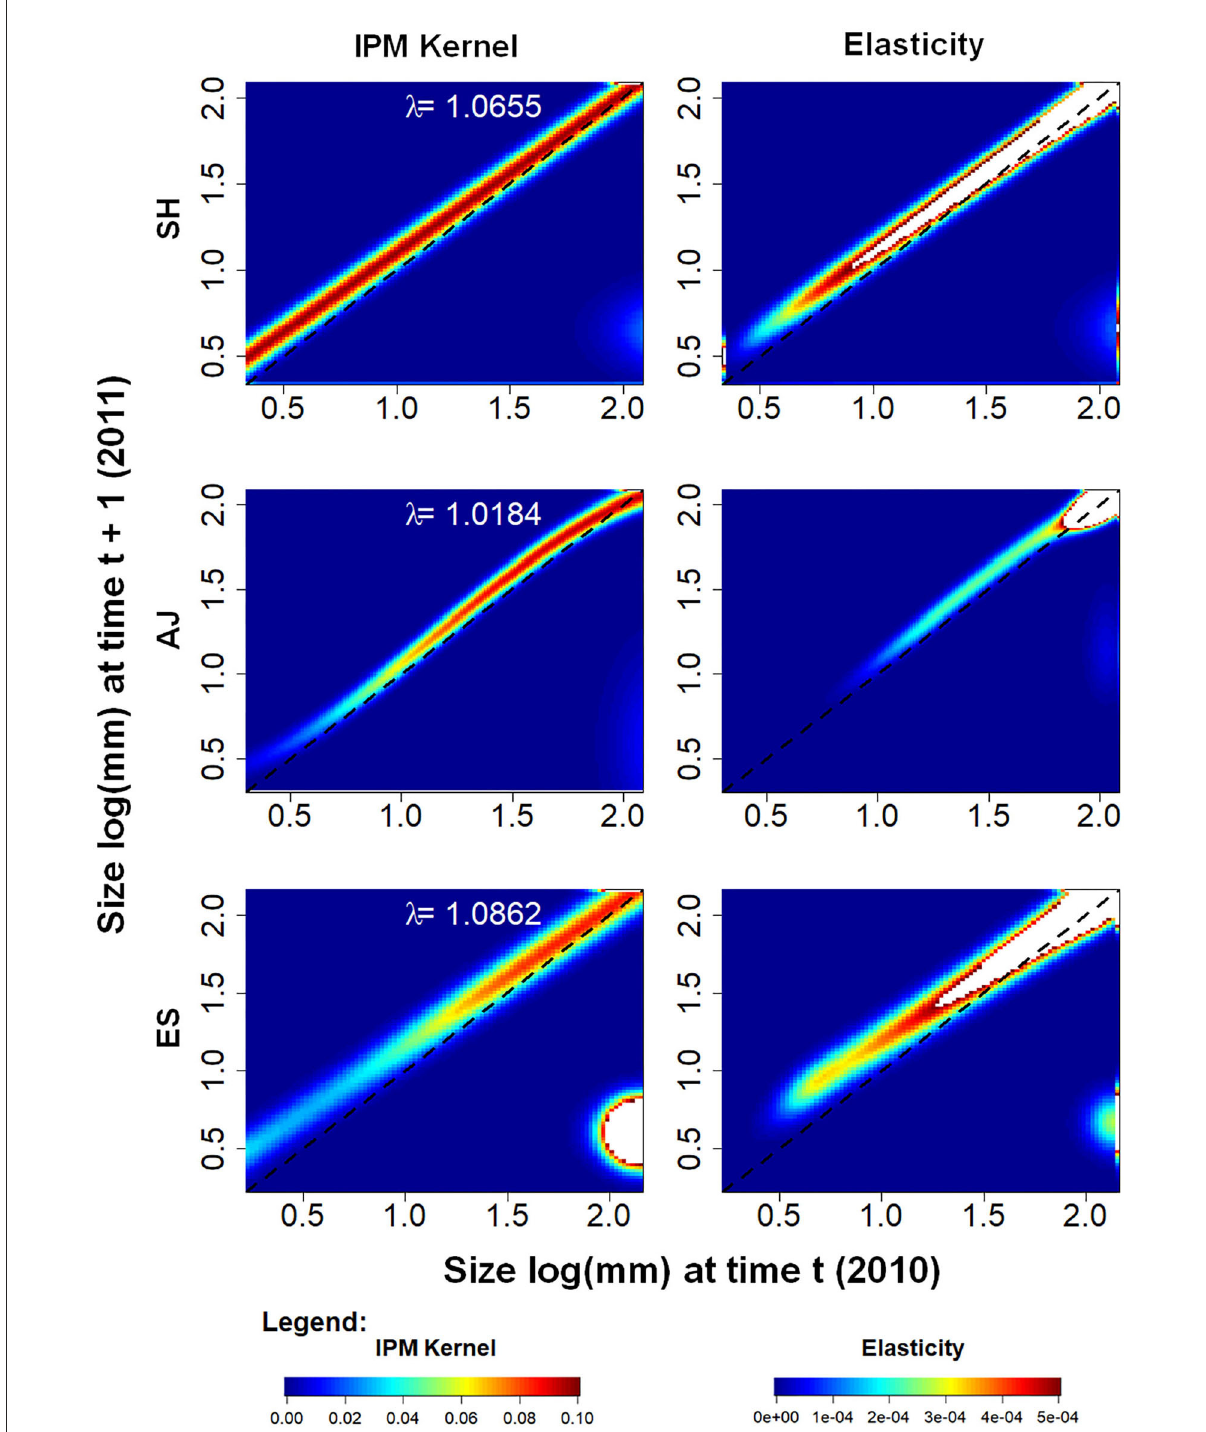
FIGURE2 Euterpe edulis demographic analysis was performed with integral projection models (IPM) for a 1-year interval (2010–2011) in three different populations (SH, AJ, and ES) located in the Silva Jardim municipality, Rio de Janeiro state, Brazil. Left: images detailing the projection kernels, built from the P function (representing survival and growth, illustrated along the main diagonal of each image), and the F function (representing fecundity rate, illustrated on the lower right of each image). Right: images detailing elasticity kernels (illustrated along the main diagonal of each image). The dashed black line along the main diagonal is used as a reference for the probability of stasis. Individuals on the line did not change in size during the period of the study, while individuals above the line increased in size and individuals below the line decreased in size. Higher transition probabilities are represented by the warmest colors (including white). The x and y axes are on a logarithmic